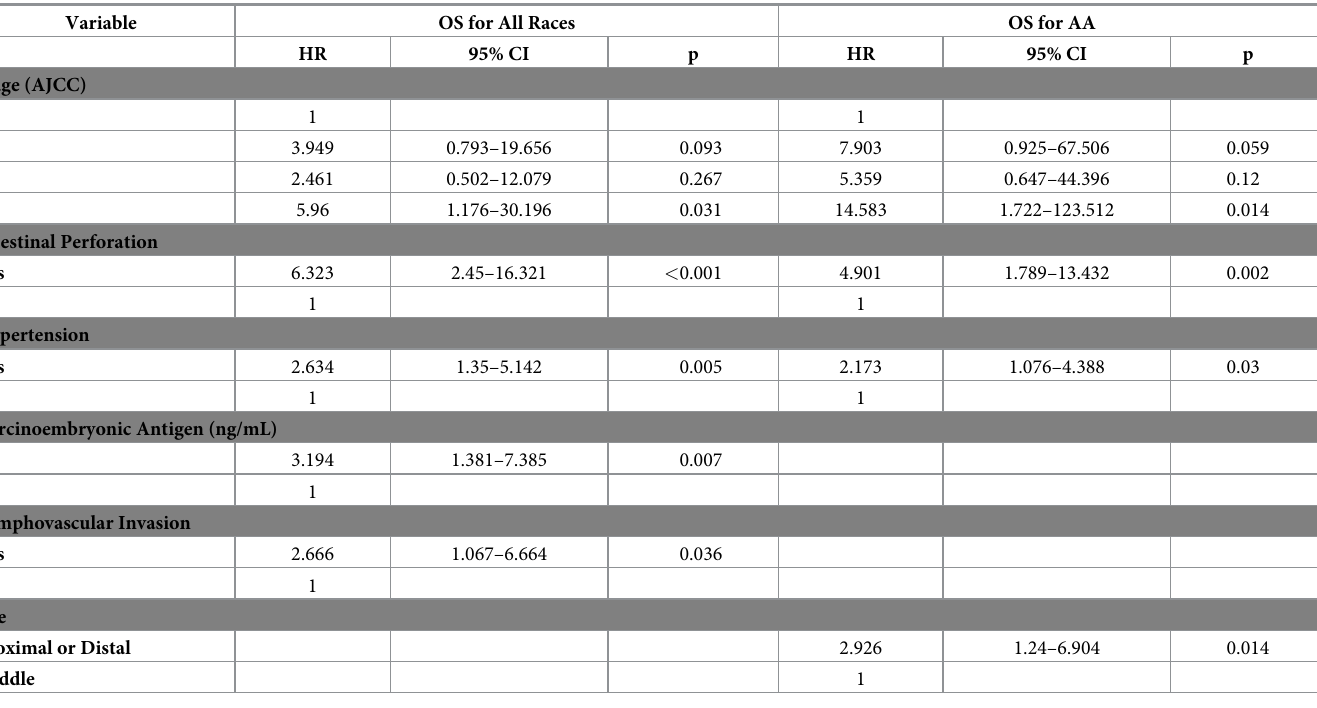
Table 3. Multivariate cox regression analysis for overall survival (OS) �